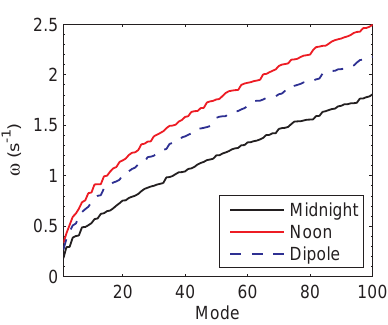
Figure 13. The first 100 eigenfrequencies for the noon side and midnight side of the compressed dipole and a standard-dipole